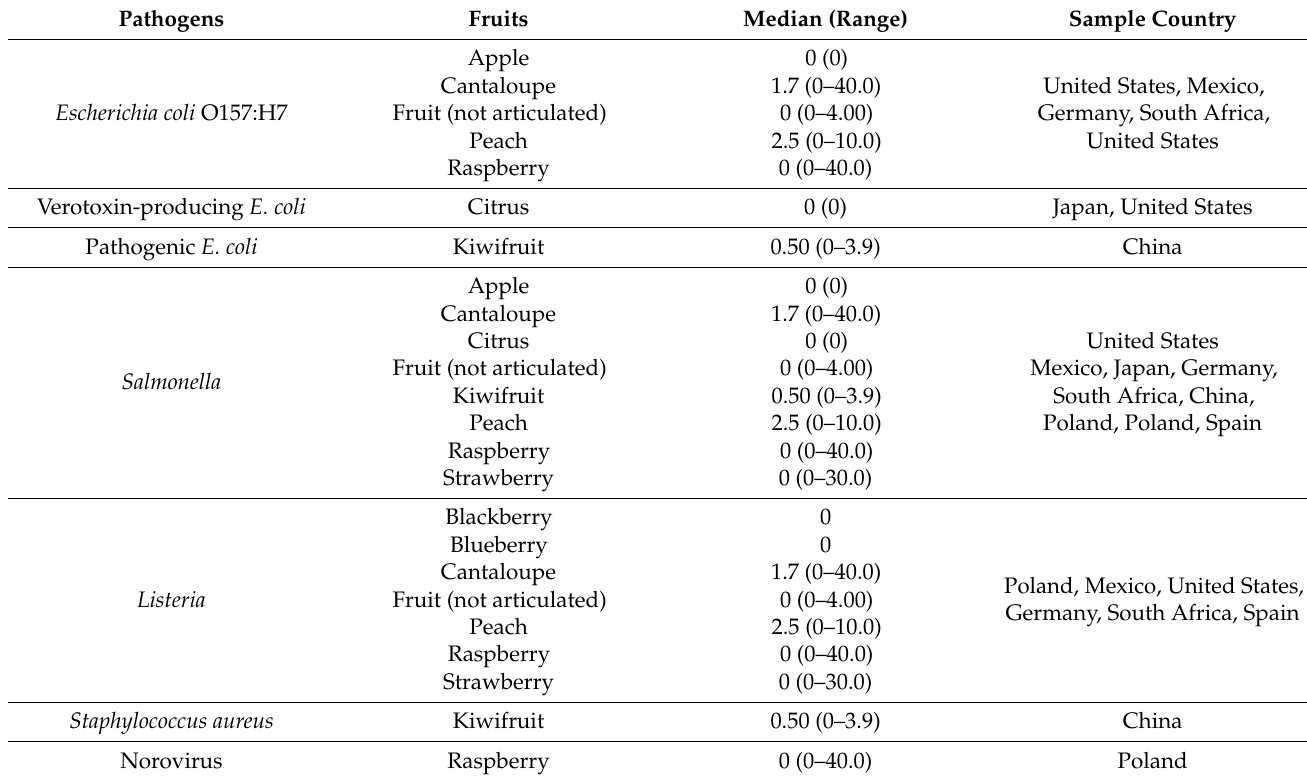
Table 1. Pathogen prevalence in fruits, median prevalence and country of prevalence, reproduced from [61]. Pathogens Fruits Median (Range) Sample Country Apple Cantaloupe Fruit (not